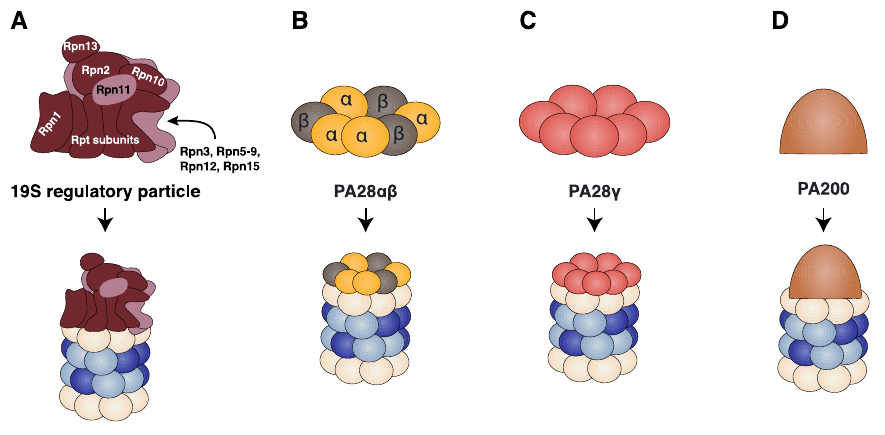
Figure 3. Proteasome regulators. ( A ) 19S regulator particle harbours two subcomplexes: the